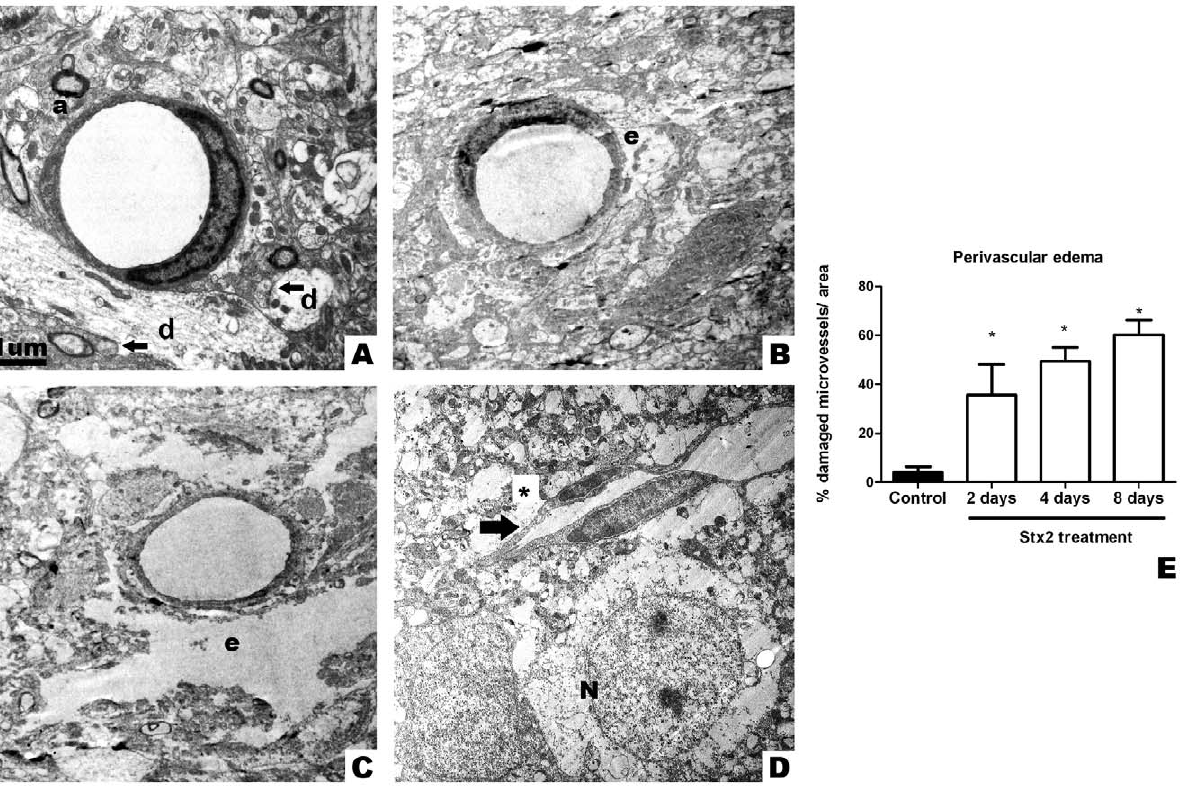
Figure 4. Intravenous administration of Stx2 causes ultrastructural alterations at the blood brain barrier level. Electron micrograph showing a conserved endothelial cell with conserved endothelial nucleus that constitutes a microvessel from a striatal brain slice after i.v. administration of vehicle; microvessel surrounded by conserved synapses (arrows), dendrites (d) and myelinated axons (a) (A). Perivascular edema (e) 2 days after i.v. administration of Stx2 (B). After 4 days: more pronounced perivascular edema (e) (C). After 8 days: infarcted microvessel (arrow) with perivascular edema (*) near a neuron (N) (D). No cytoplasmic membrane is observed in the neuron at this stage. Quantification of the percentage of damaged microvessels by perivascular edema (E). Damage in microvessels begins to be significant on day 2 and is maximum on day 8 (*). Results are expressed as a percentage of the total number of microvessels in an area of 3721 m m 2 . Data are mean 6 SEM of 6–8 experiments (G). An asterisk denotes statistical significance, p , 0.05. The scale bar in A applies to micrographs